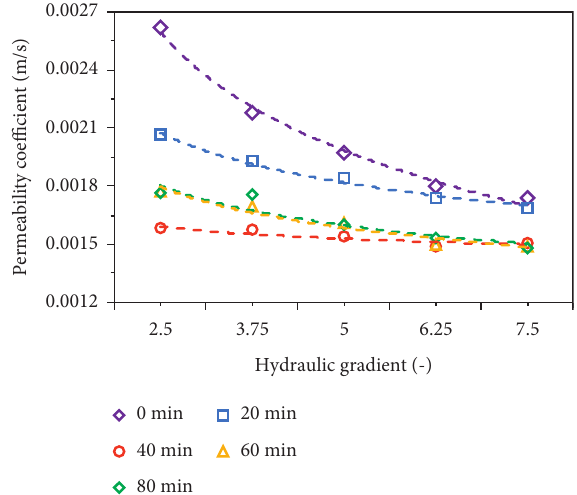
Figure 7: Plot of the variation of the permeability coefficients of PUPM 8-H at different hydraulic gradients during the clogging periods of 20, 40, 60, and 80